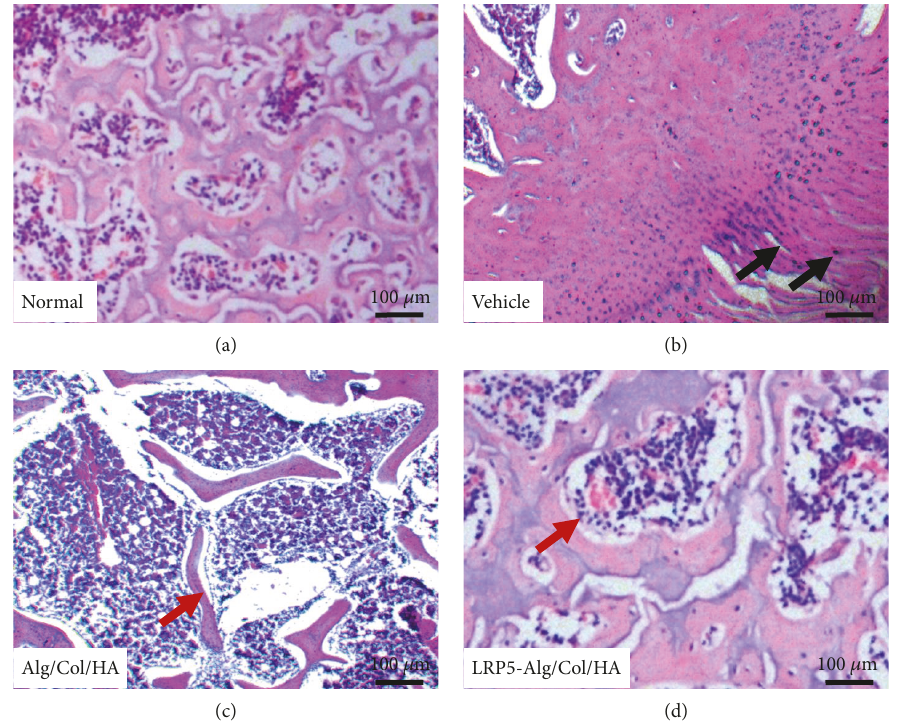
Figure 7: H&E staining of defect sites of a rat model of calvarial critical defect after 6 weeks ’ treatment. Black arrow indicates fi brous tissue, and red arrow indicates trabecular